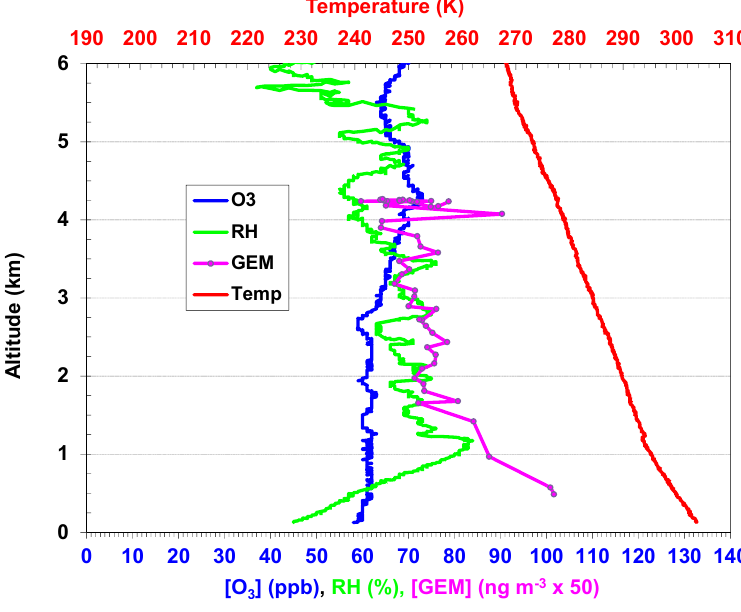
( Right ) vertical profiles of aircraft GEM concentration and ozonesonde data, including ozone, relative humidity, and temperature. The ozonesonde was launched at 10:55 CST on 6 August